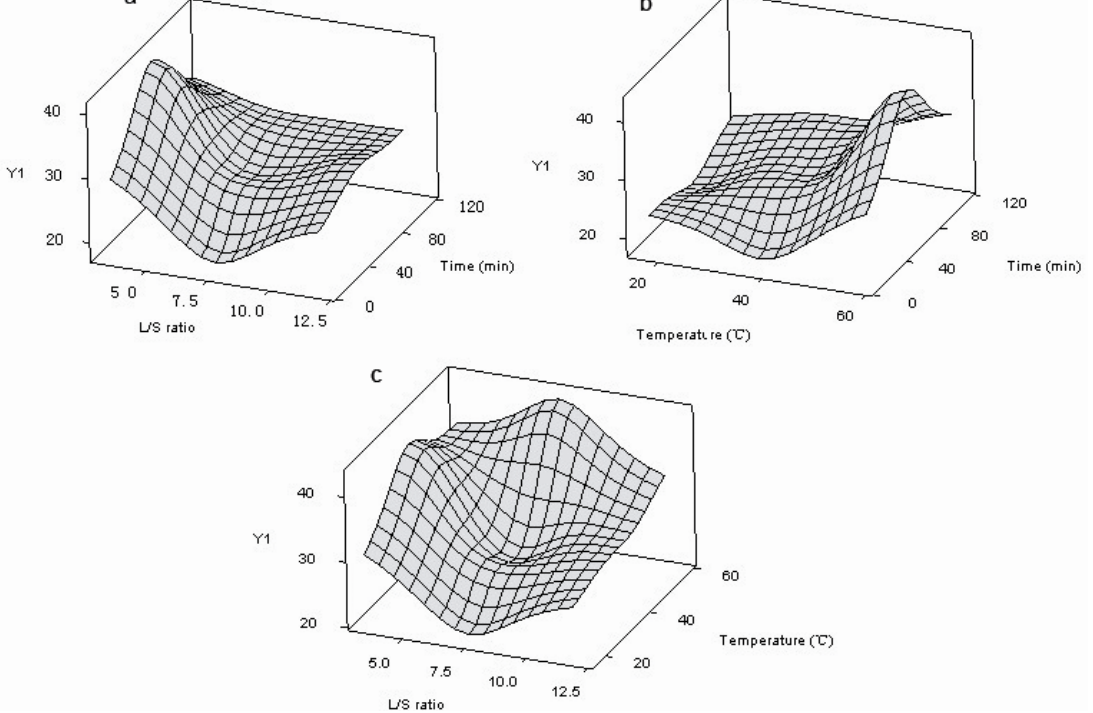
); (b) Response plot of contact time ( U 3 ) vs. L/S ratio ( U 2